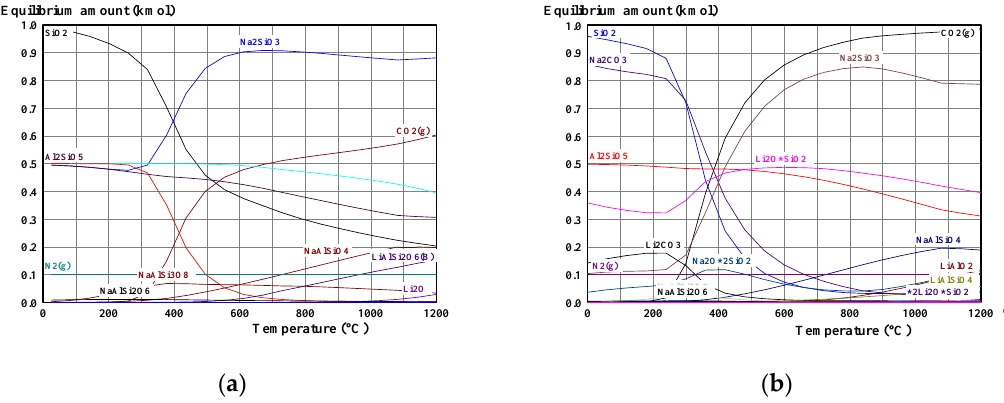
Figure 5. Equilibrium amounts versus temperature for chlorination of spodumene using ( a ) CaCl 2 , ( b ) Cl 2 and ( c ) KCl (data from HSC Chemistry 5.1 software).